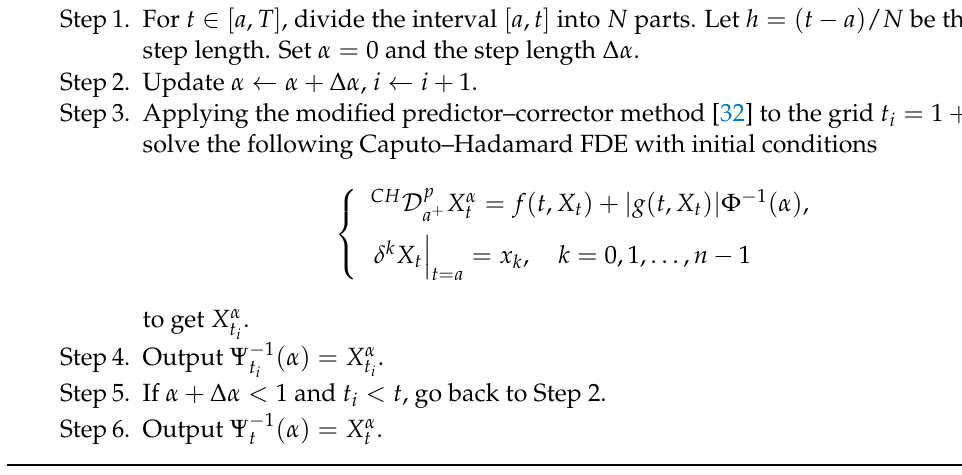
Algorithm 1: Inverse uncertainty distribution of the solutions of Caputo– Hadamard